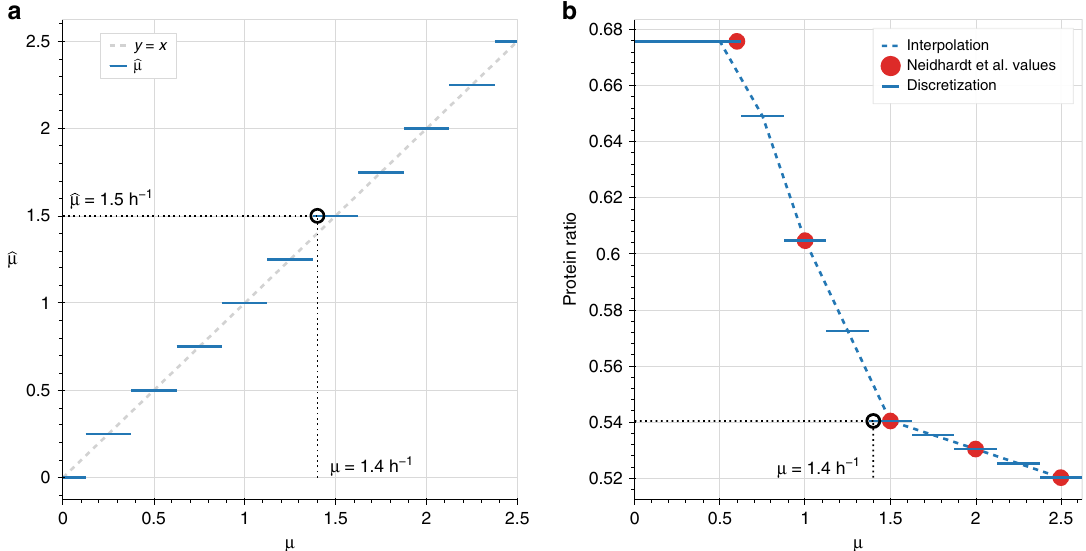
Fig. 6 Discretization example for speci fi c growth rate and growth-dependent parameters. a Discretization of μ into b μ . The step approximation transforms the continuous interval 0 ; 2 : 5 ½ (cid:3) into the discrete set 0 ; 0 : 25 ; ¼ ; 2 : 5 f g . b Example of piecewise linear interpolation and discretization of the protein mass ratio from Neidhardt et al. 11 . Red circles represent the values reported. The dashed line is the piecewise linear interpolation. The solid line is its